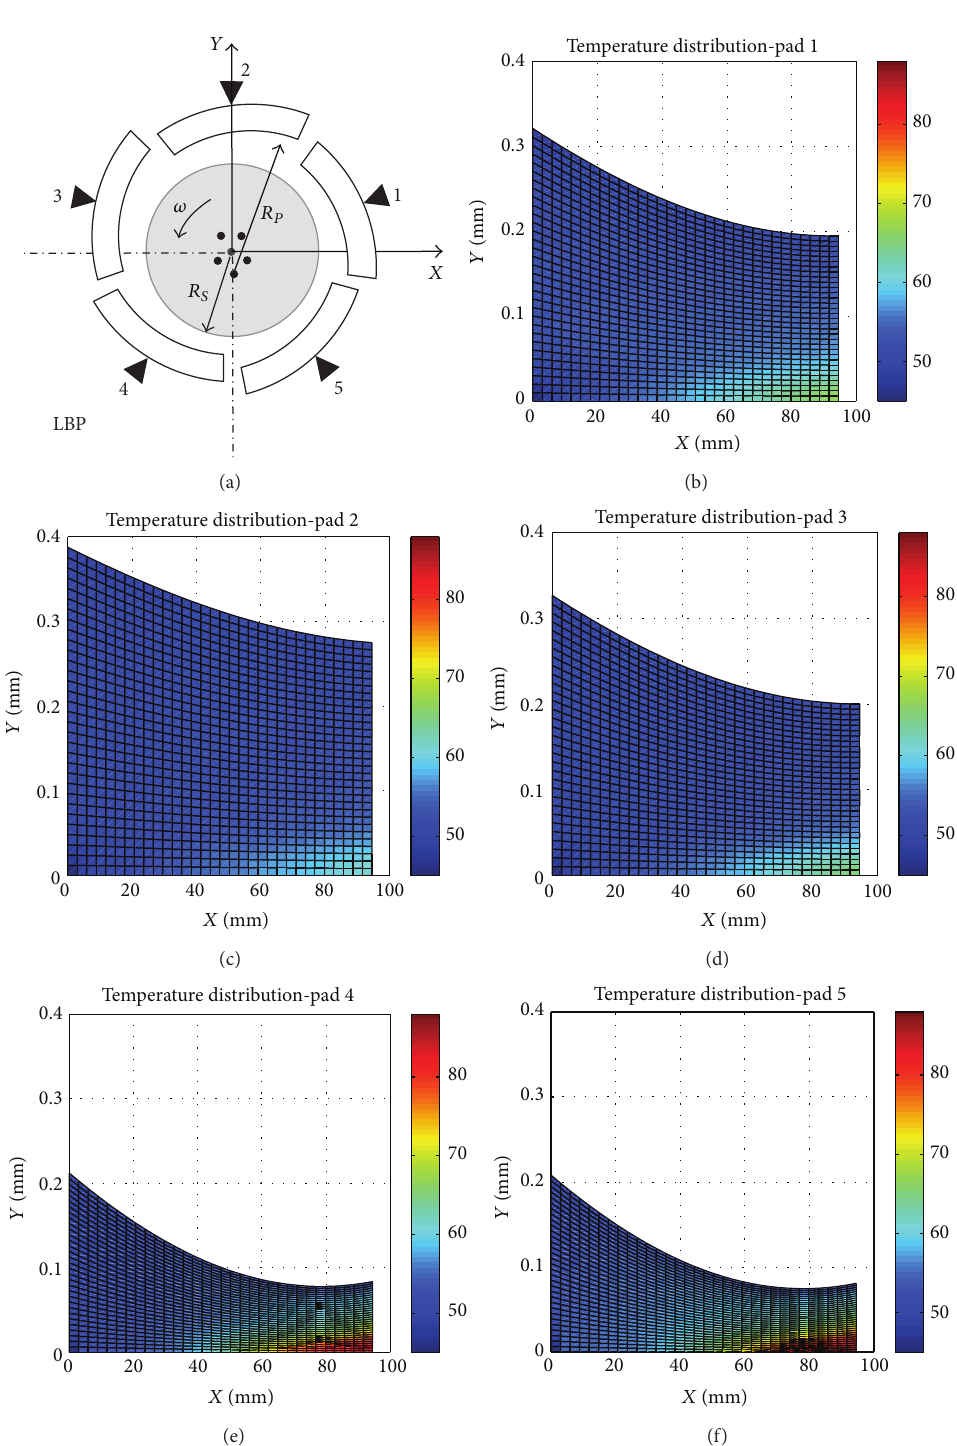
Figure 15: Temperature distribution on the pads obtained from the greater radial clearance and the maximum rotational speed: (a) bearing configuration; (b) pad 1; (c) pad 2; (d) pad 3; (e) pad 4; (f) pad